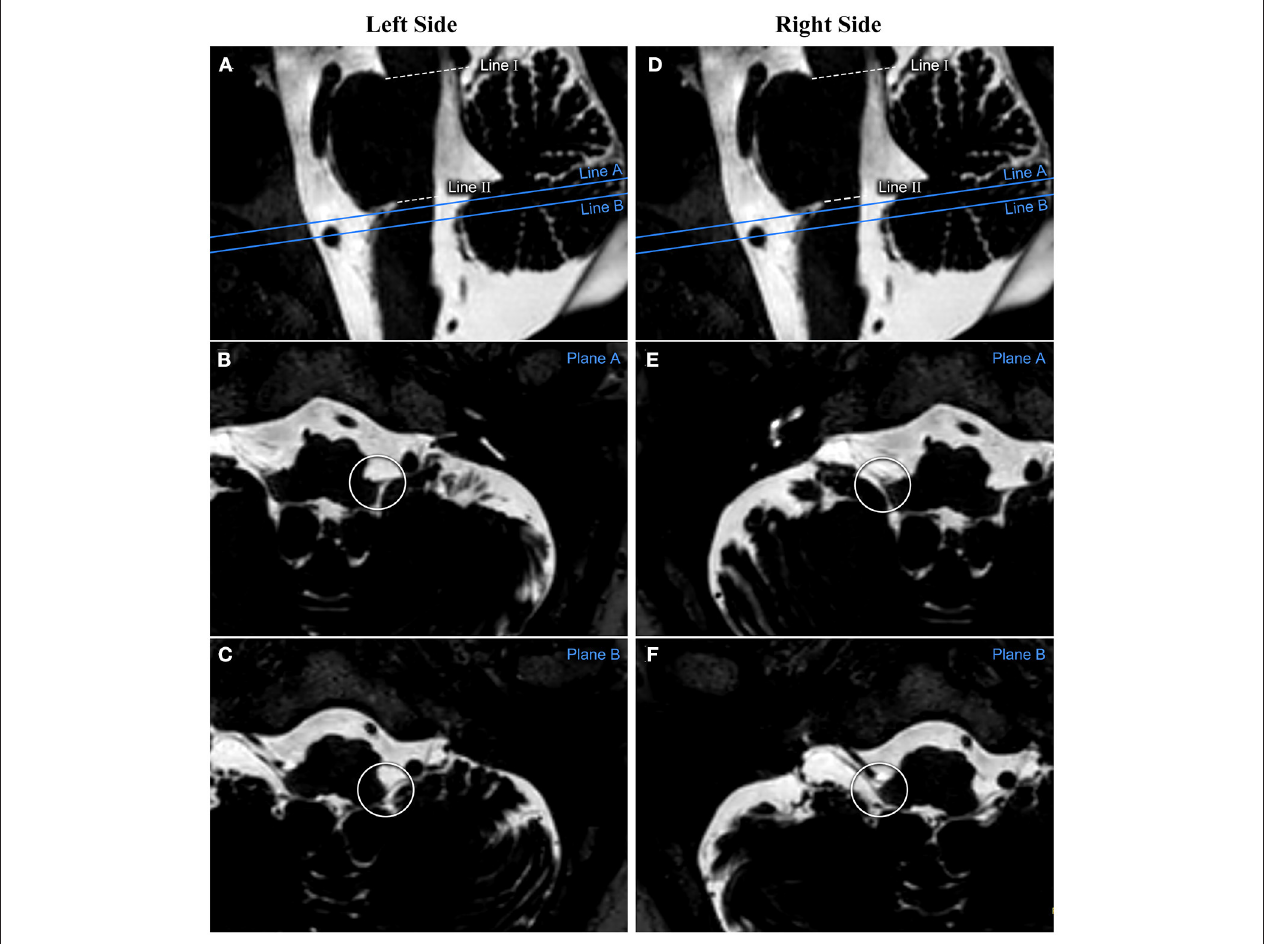
FIGURE 2 | The measurement process performed on one patient’s reconstructed image. The relationship between CN IX-X and the medulla oblongata is assessed based on the reconstructed transverse plane images. The cephalic and caudal planes of the CN IX-X REZ are marked on the sagittal image as planes (A,B) , respectively. (A–C) show the measurements from the patient’s left side. (D–F) show the measurements from the patient’s right side. CN, cranial nerve; REZ, root entry/exit